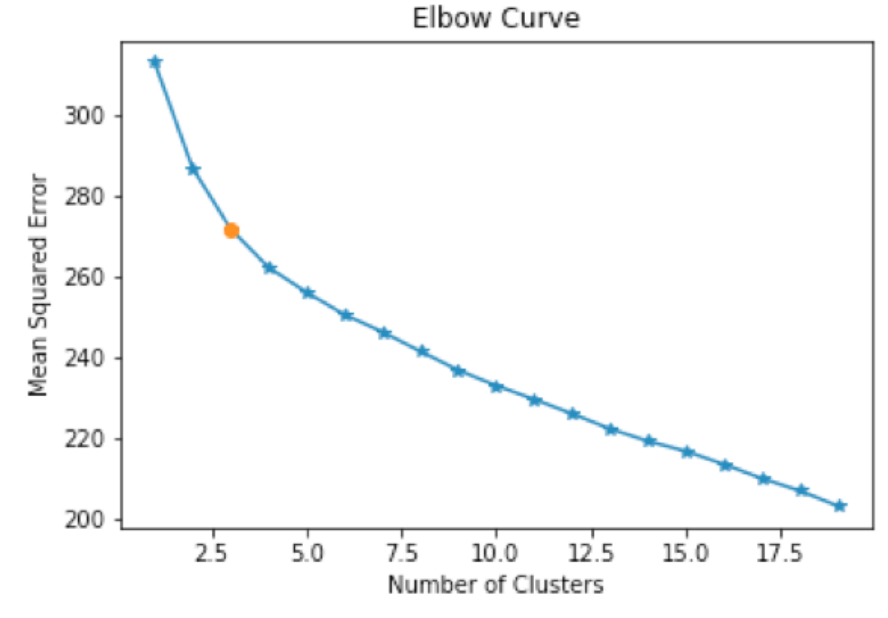
Figure 1. Elbow curve used to determine the number of clusters to be used in K-means clustering. On the x-axis are the number of clusters which the algorithm was set to fit and on the y-axis is the mean squared error of the clustering. The red dot is located at the mark which corresponds to 3 clusters and corresponds to the closest number of clusters to the “bend” of the elbow curve.